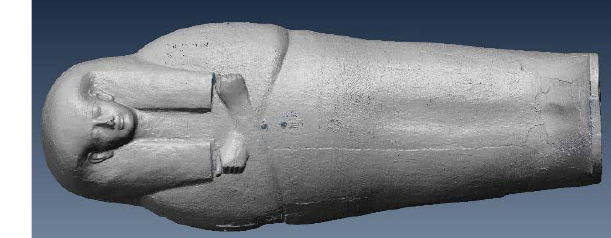
Figure 7. The discrete 3D model, in grey scale the point’s reflectance is represented.